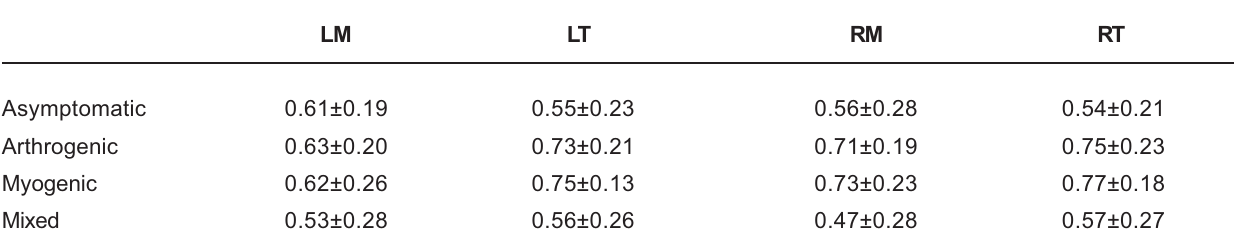
LM = Left Masseter; LT = Left Temporal; RM = Right Masseter; RT = Right Temporal. TABLE 3- Normalized RMS means (±standard deviation) during isotonic contraction four the 4 evaluated groups